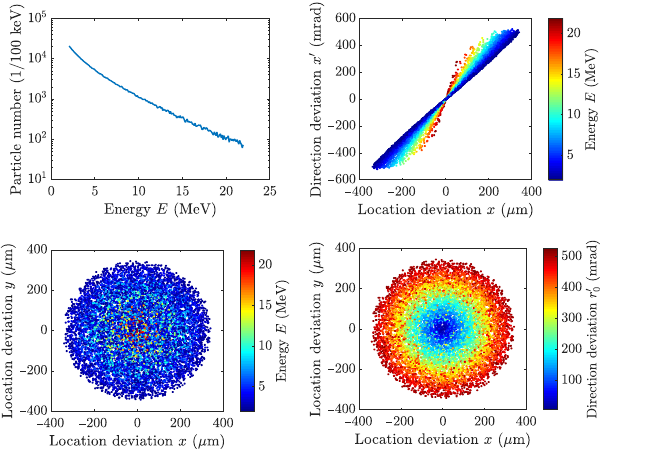
FIG. 2. Energy spectrum and correlation between the location deviation x , the direction deviation x 0 , the initial direction deviation r 0 0 , and the energy E of a TNSA beam with protons generated by the LIGHT simulation.